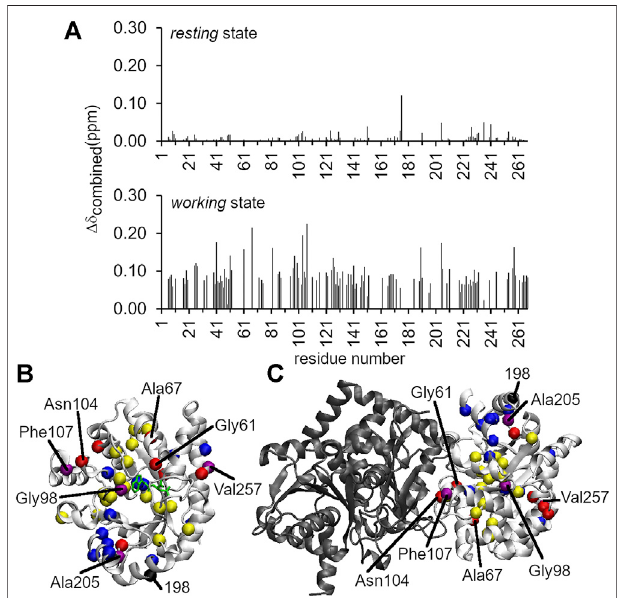
FIGURE3| Long-rangestructuralanddynamicchangesinducedbythe A198W substitution. (A) 1 H – 15 N chemical shift perturbations induced by the A198W substitution. The Δ δ combined values were determined according to the equation, ( Δ δ combined (cid:1) ( Δ δ HN2 + ( Δ δ N /5) 2 ) 0.5 , where Δ δ HN and Δ δ N were the 1 H and 15 N amide chemical shift differences between WT and A198W. Chemical shift differences between WT and A198W α TS are shown for both the ligand-free resting state (top; average Δ δ combined < 0.01 ppm), and the actively turning over working state (bottom; average Δ δ combined (cid:1) 0.04 ppm). Residueswith Δ δ combined valuesgreaterthan0.15 ppmandbetween0.10and 0.15 ppm for the working state are plotted as red and yellow spheres, respectively, onto the structures of (B) α TS and (C) the full TS complex. Networkresiduesareplottedasbluespheres,oraspurplespheresiftheymet the Δ δ combined thresholds (i.e., > 0.10 ppm). Most of the network residues showed chemical shift perturbations but may not have met this threshold.